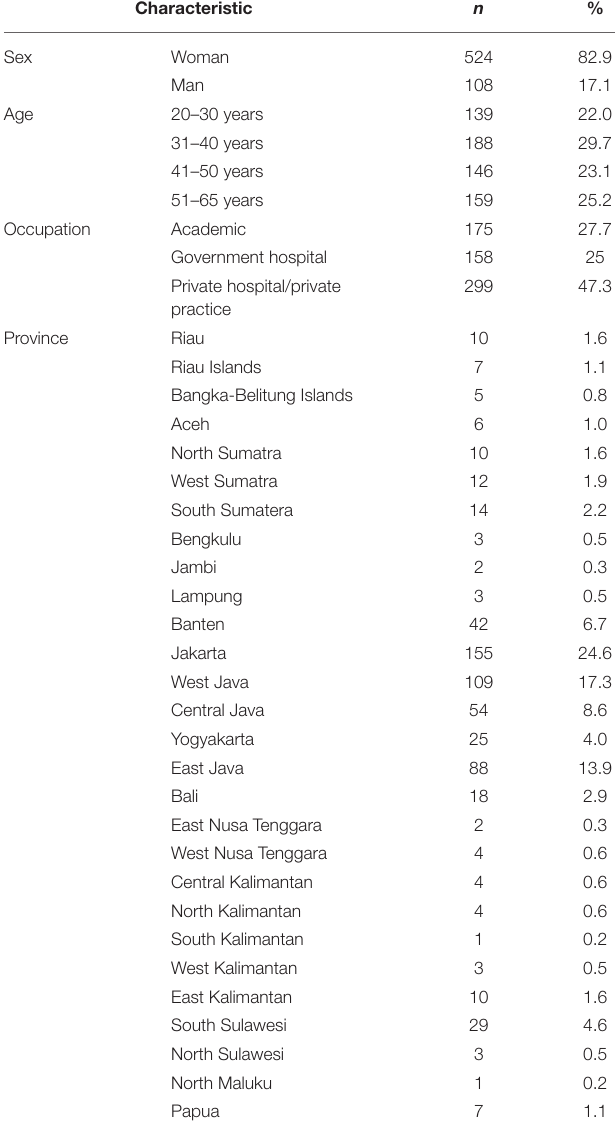
TABLE 1 | Demographic characterisatic of